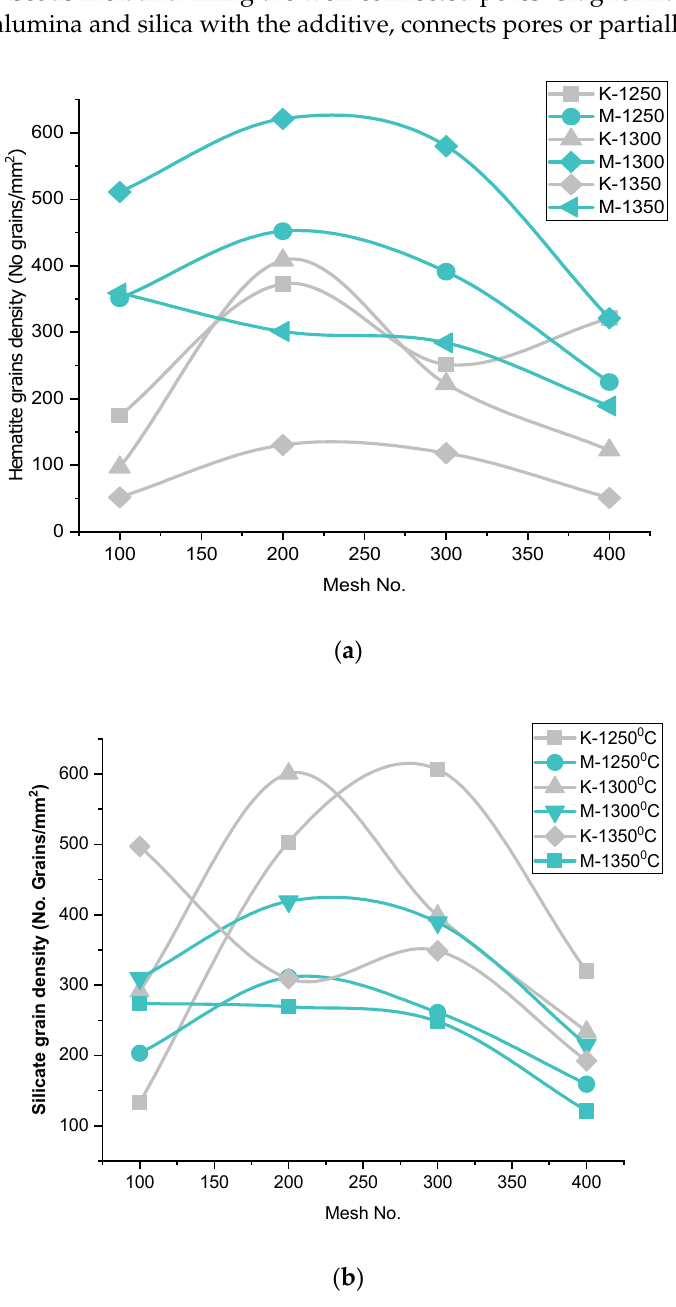
Figure 9. Effect of Mesh no. on Phase Grain density of ( a ) Hematite ( b )